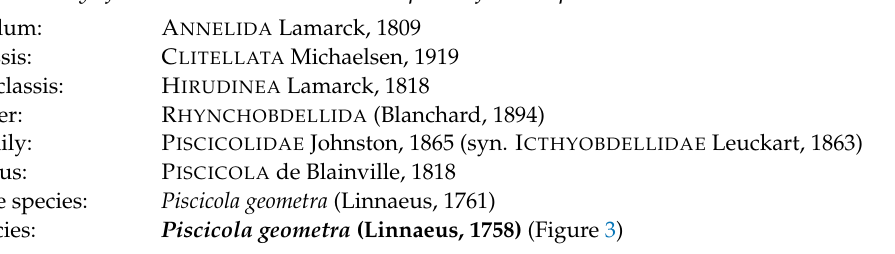
Neotype : Russia, Temernik River in Rostov Region, a right tributary of the Don, from aquatic vegetation, leg. E. Matveenko (28-X-2015).